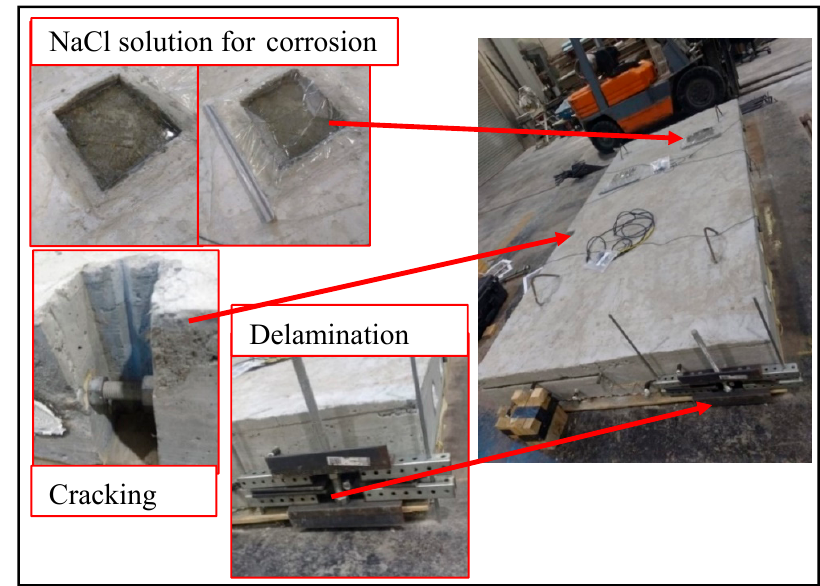
Figure 4. Specimen Set 2 and various areas of artificially introduced flaws.